Question: Summarize what this figure shows in one sentence.
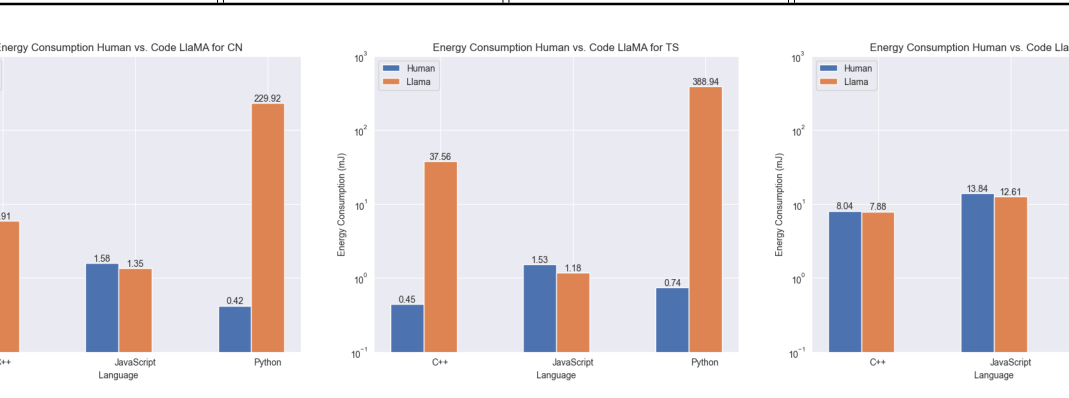
Answer: Average energy consumption of human and generated code (in log scale).